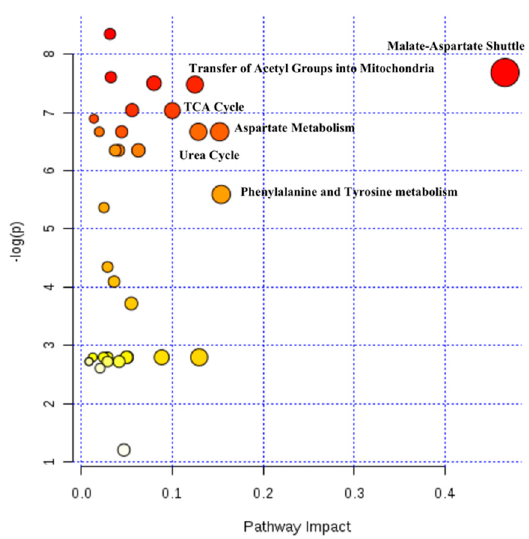
Figure 4. Overview of the dysregulated metabolic pathways based on metabolites alteration caused by hyperthermia. The node color is based on the p value, where a dark circle color indicates a more significant pathway. The node radius corresponds to the pathway impact value. Pathways were annotated when p < 0.05 and pathway impact > 0.1.